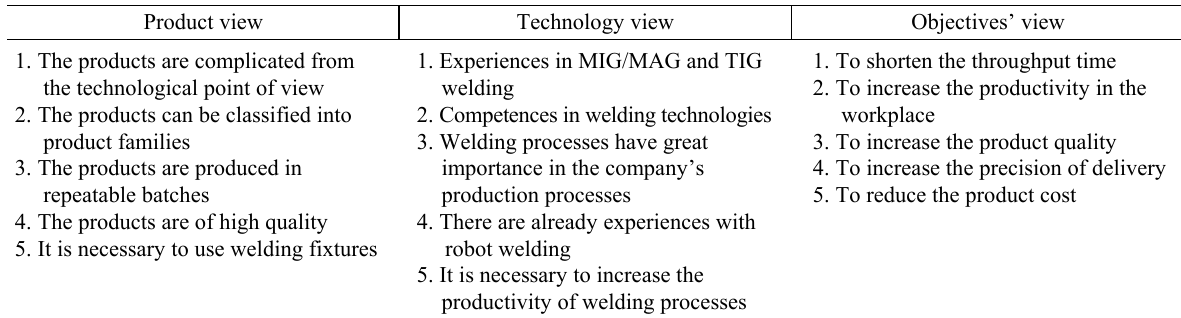
Table 1. Suitability criteria for robot